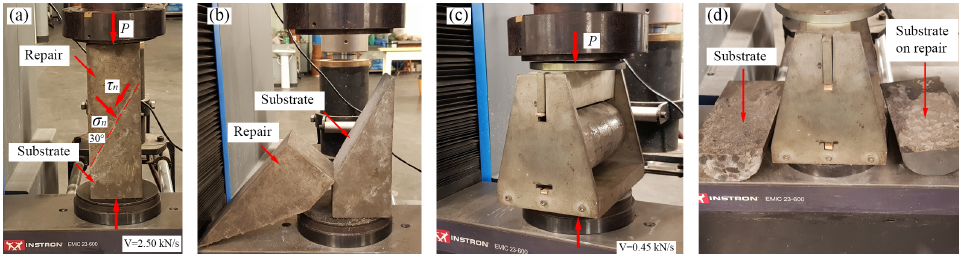
Figure 1. Slant shear and splitting tensile tests: ( a ) slant shear test; ( b ) bond failure; ( c ) splitting tensile test; ( d ) bond failure.